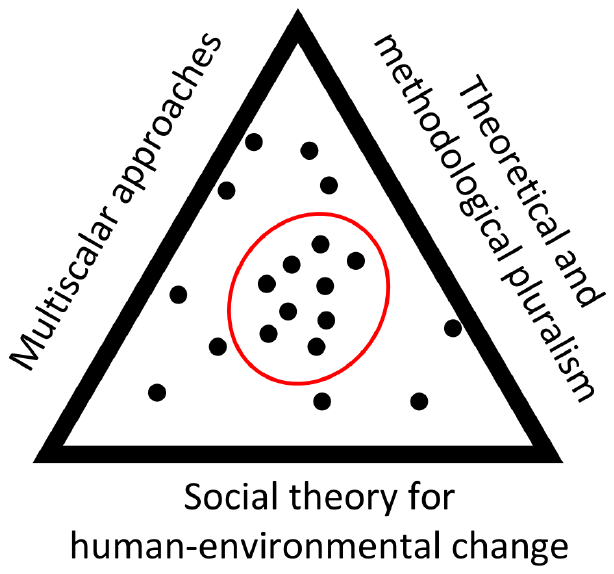
Fig. 3 . Three characteristics of critical problem-solving theses in sustainability